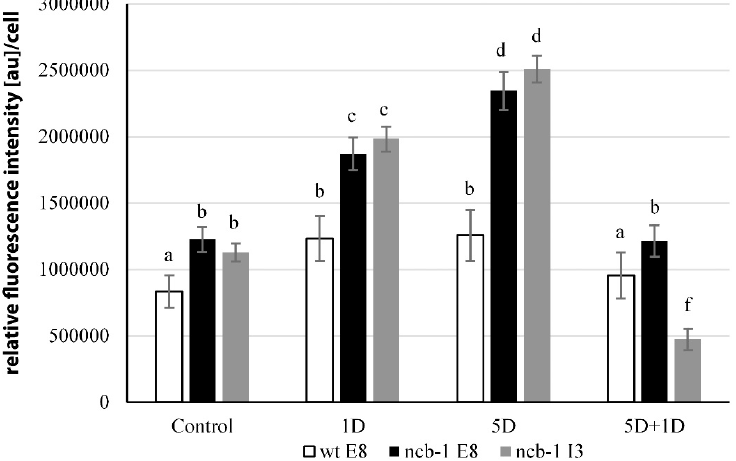
Figure 7. Measurements of the amount of RPB1 mRNA with exon 8 and intron 3 in nuclei wt and ncb-1 in normoxia (Control), hypoxia (1D, 5D) and reoxygenation (5D + 1D). Variants labeled with the same letters are not significantly different ( p ≤ 0.05).